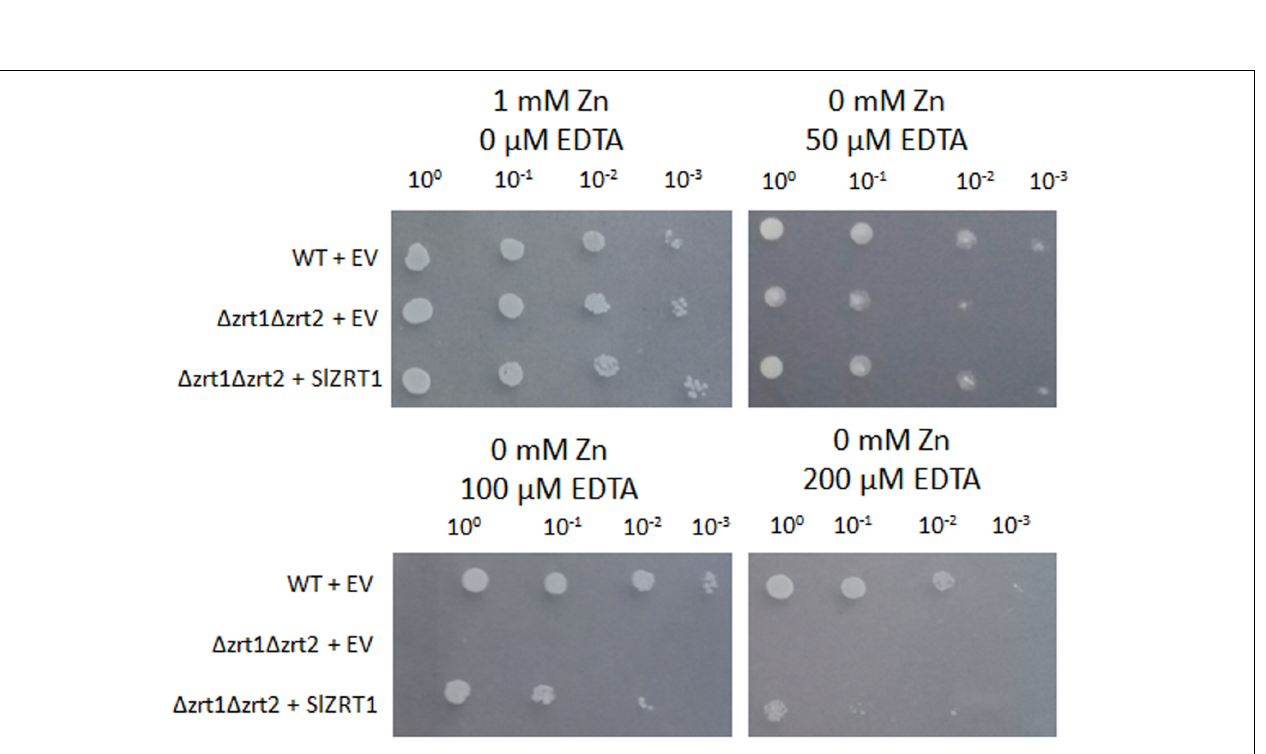
Frontiers in Microbiology |